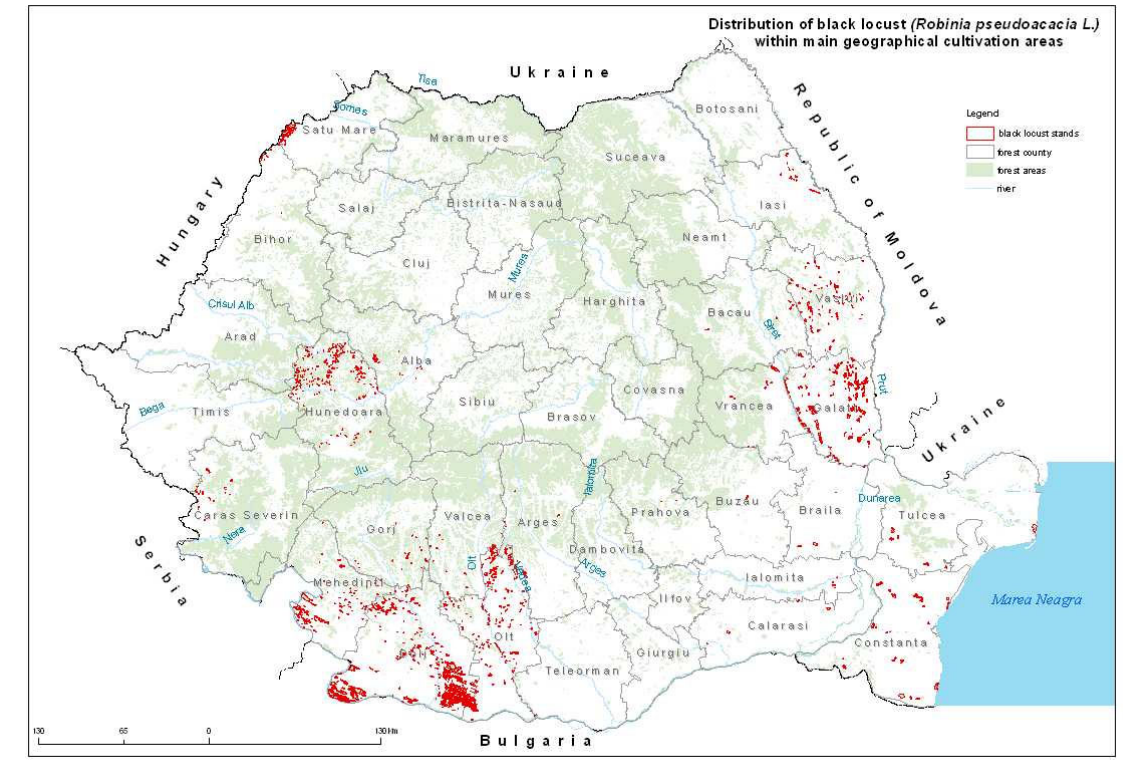
Figure 1. Distribution of black locust stands in the main culture regions of Romania [10].